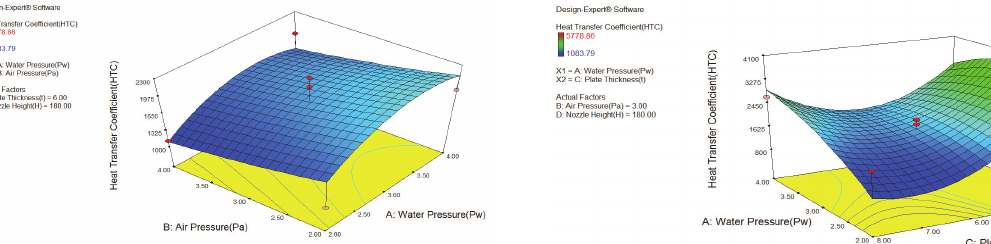
Fig. 3. Variation of HTC with respect to water pressure and plate thickness